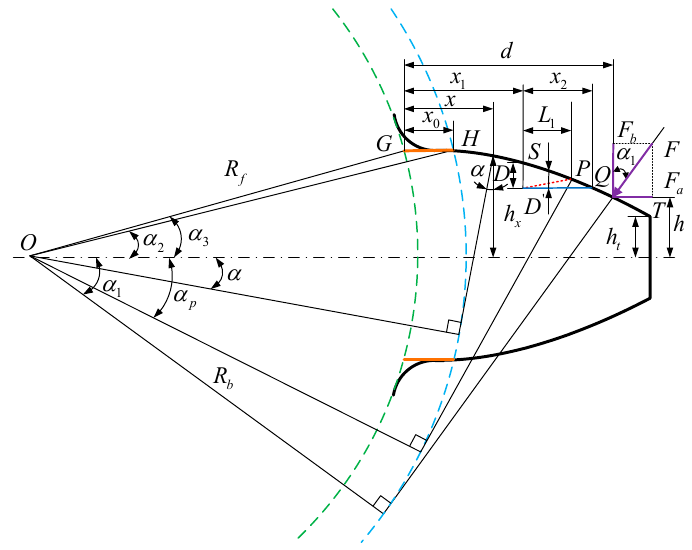
Figure 1. Geometric parameters of tooth surface crack.